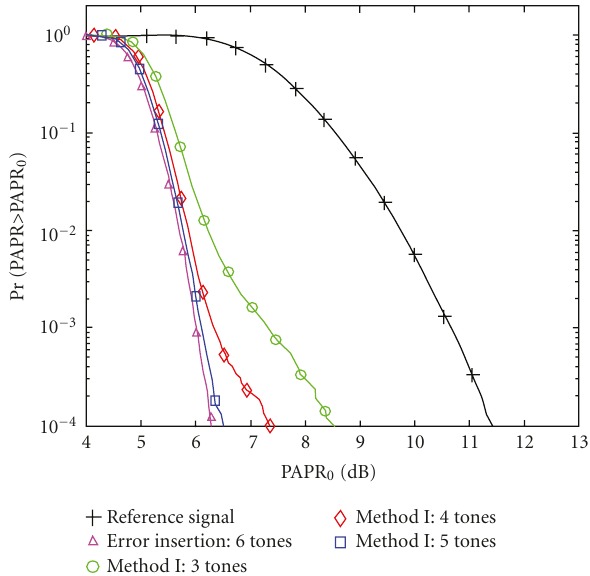
Figure 6: Method I: CCDF of OFDM system with 64 tones and 16-